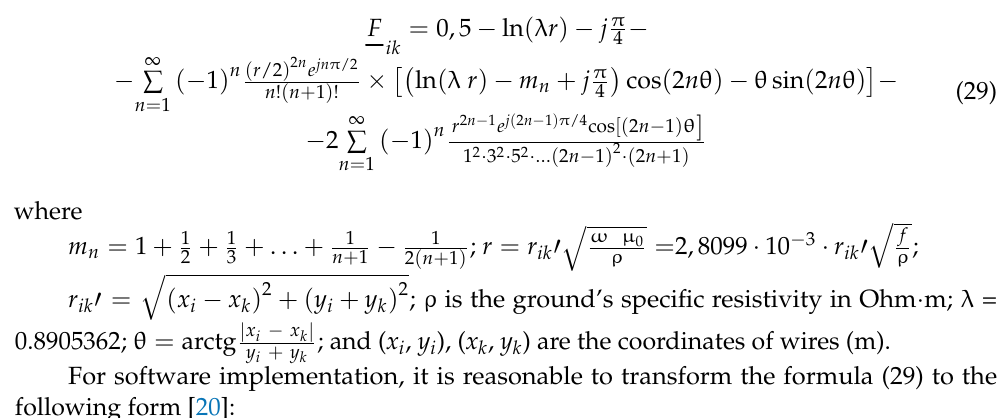
Phase coordinates are the most natural description of three-phase power systems.